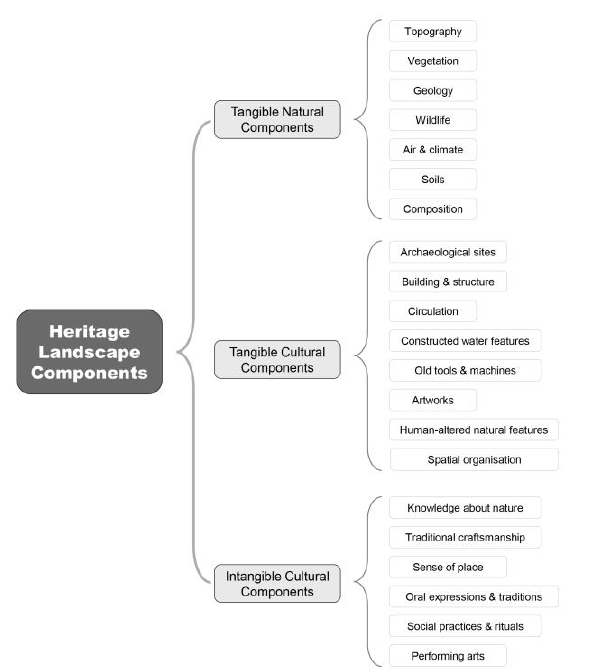
Figure 1. Heritage landscape components identified from case studies